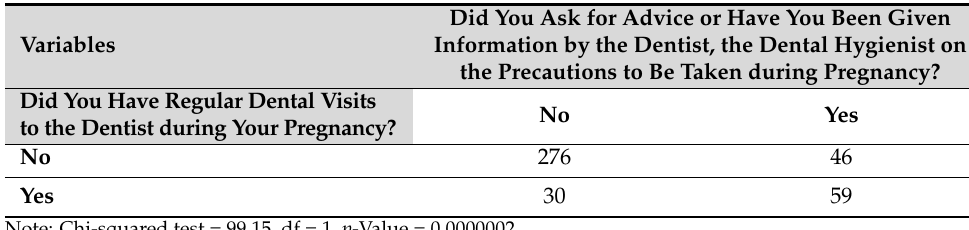
Table 2. Distribution according to information received by dental professionals.